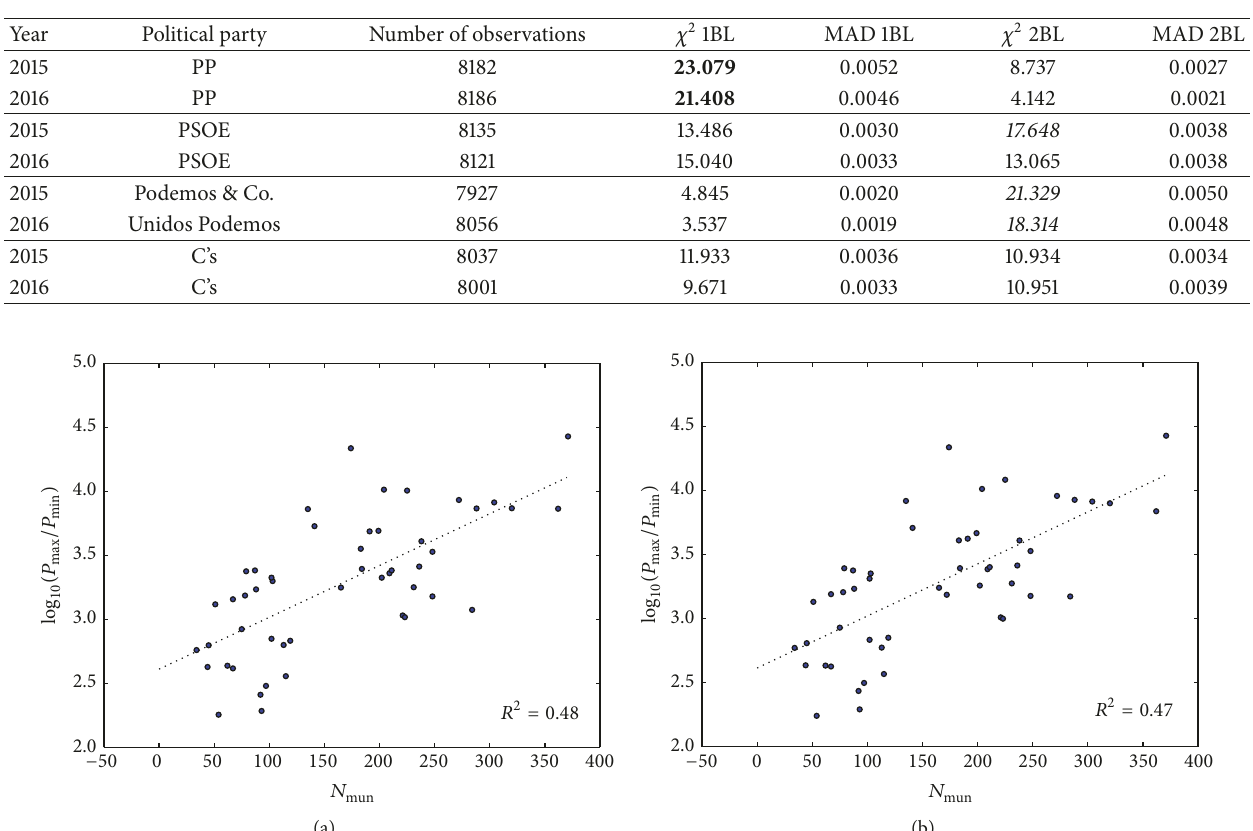
Table 1: Statistical tests of conformance to Benford’s law for the first (1BL) and second (2BL) significant digit distribution for the vote counts of each political party (at the level of municipalities), along with 𝜒 2 and MAD statistics. In italic we highlight the datasets where the null hypothesis can be rejected with 95% confidence but not with 99% and in bold cases for which where the null hypothesis can be rejected with more than 99% confidence according to 𝜒 2 . On the basis of MAD statistic the null hypothesis of conformance to Benford’s laws cannot be rejected for any case.